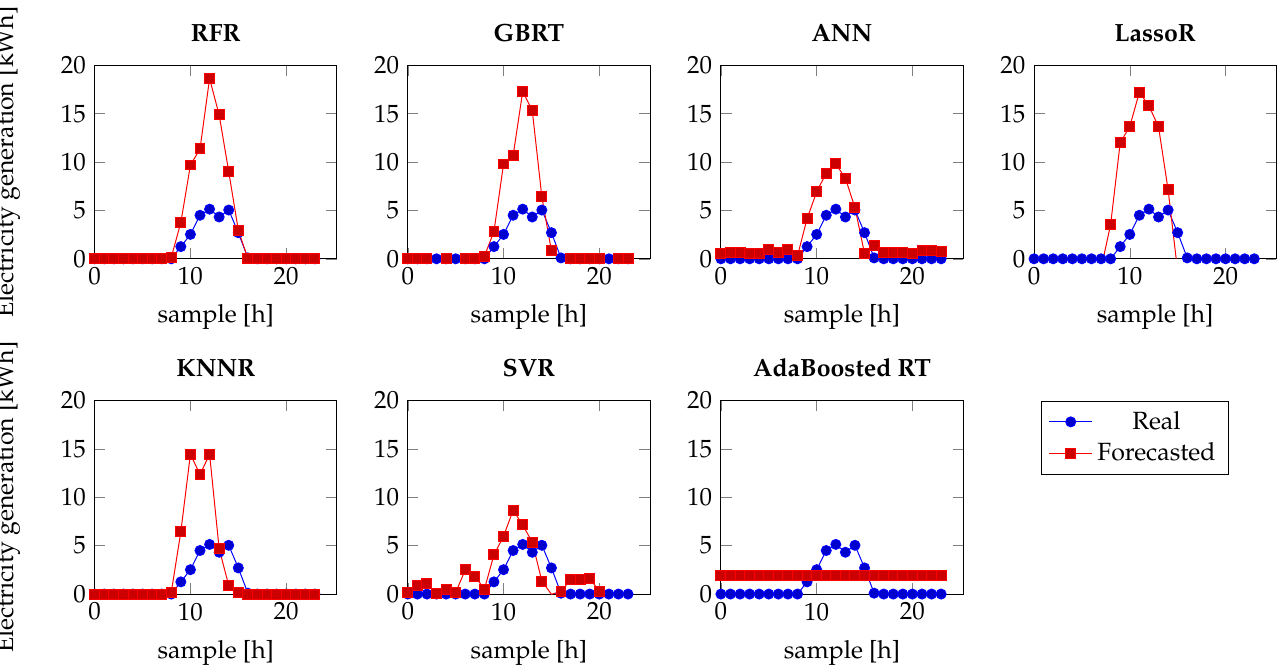
Figure 5. Forecasting results for a chosen day in which low compliance was achieved.